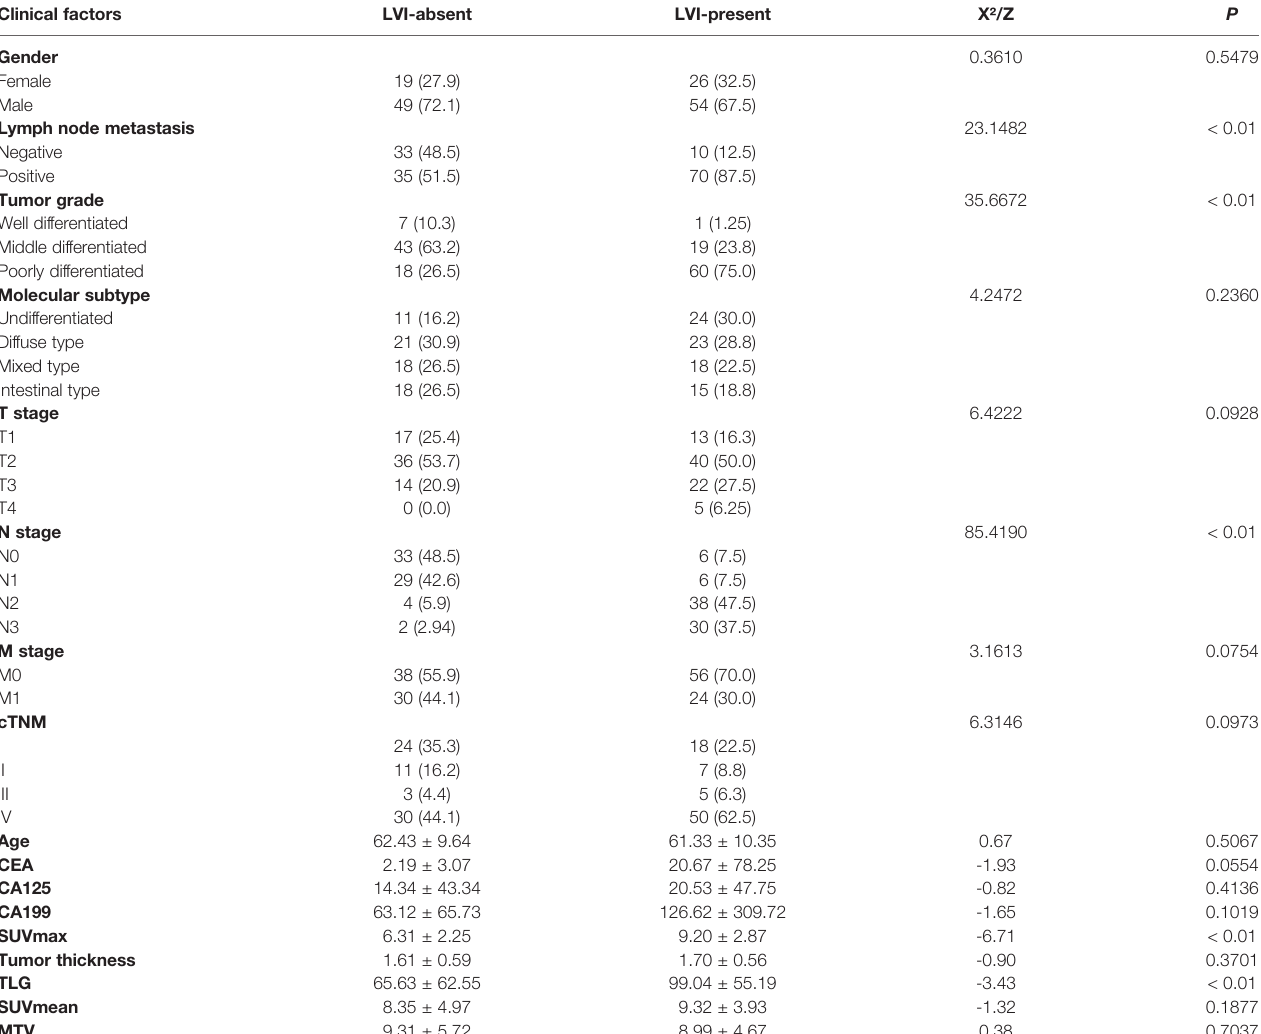
TABLE 1 | Baseline clinical characteristics of patients. Clinical